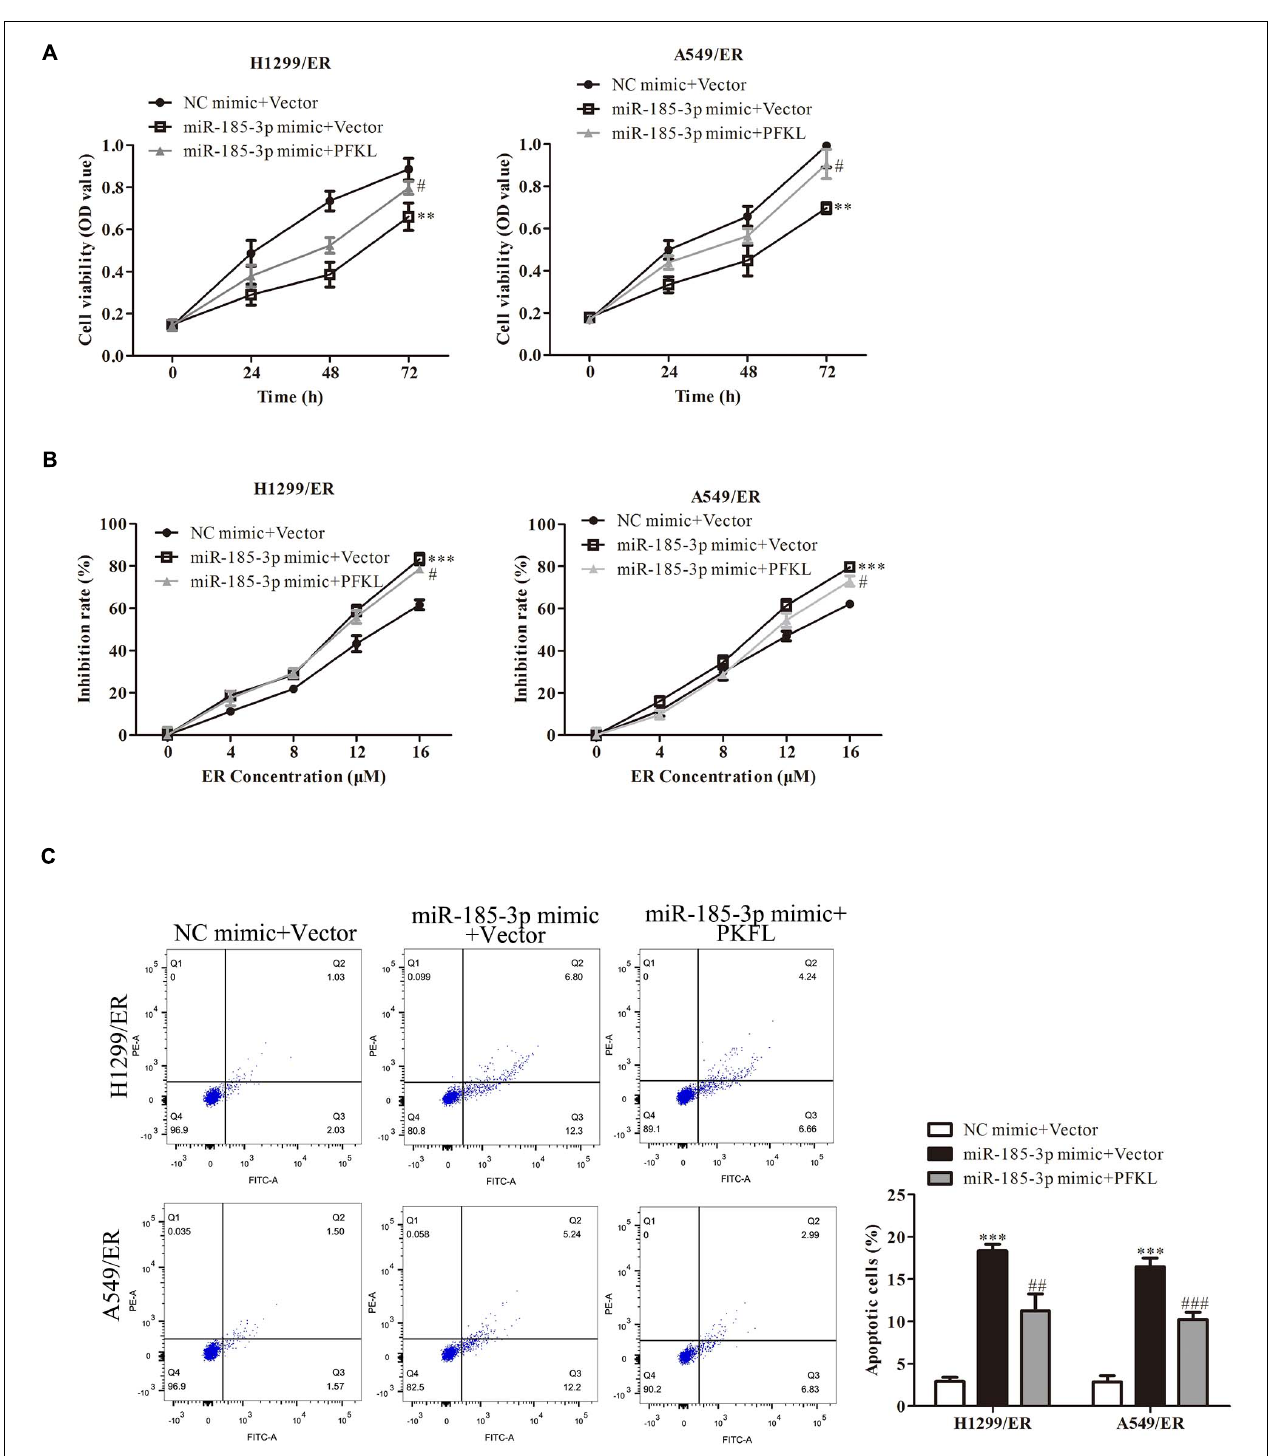
FIGURE 5 | Liver-type phosphofructokinase inhibits tumor cell proliferation and ER resistance. (A) Cell viability was determined by CCK8 assay in H1299/ER and A549/ER cells at 24, 48, and 72 h. (B) The inhibition rate was determined with various ER concentrations from 0 to 16 µ M in H1299/ER and A549/ER cells. (C) Cell apoptosis was determined using flow cytometry assay in H1299/ER and A549/ER cells. Data were shown as mean ± SD. ∗∗ p < 0.01; ∗∗∗ p < 0.001 vs. NC mimic + Vector, # p < 0.05, ### p < 0.001 vs. miR-185-3p mimic + Vector.